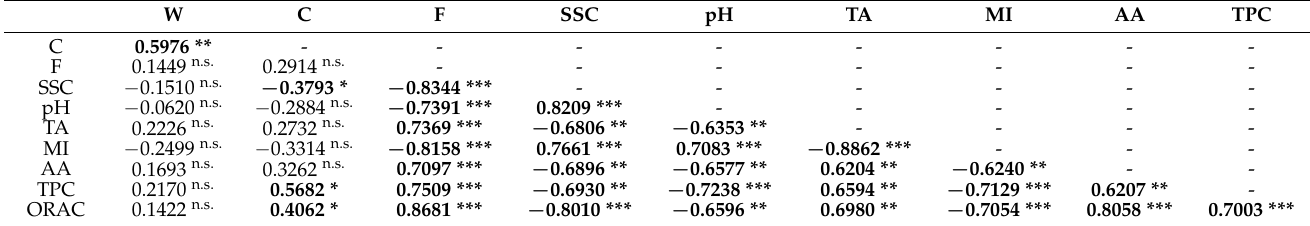
Table 5. Pearson’s correlation matrix (r) for analysed. Significant interactions are highlighted in bold. The parameter r represented in this table ranges from 1 to − 1 depending on whether the correlations between parameters are positive or negative respectively. The variables analysed were: weight (W), calliper (C), firmness (F), soluble solid content (SSC), pH, total acidity (TA), maturity index (MI), ascorbic acid (AA), total phenolic compounds (TPC) and antioxidant capacity (ORAC). The data used are from the final day of the study (day